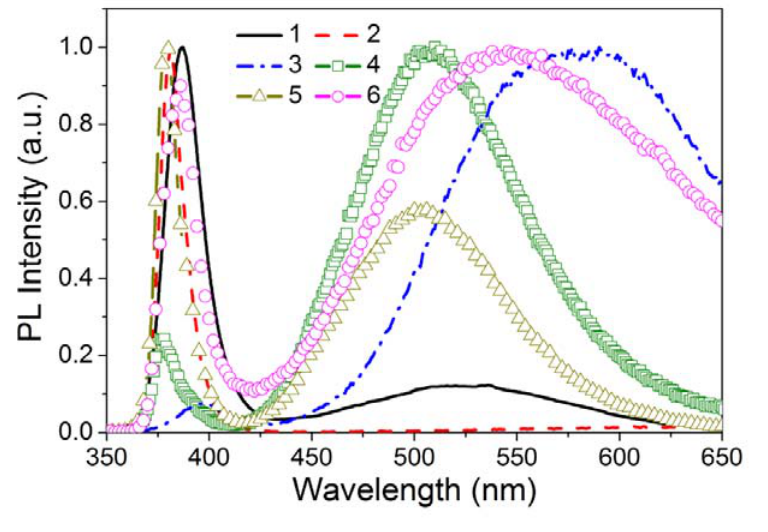
Figure 11. Room temperature PL spectra of various ZnO nanostructures: (1) tetrapods, (2) needles, (3) nanorods, (4) shells, (5) highly faceted rods, and (6) ribbons/combs, [reproduced with permission from [128]. Copyright Wiley-VCH Verlag GmbH & Co.